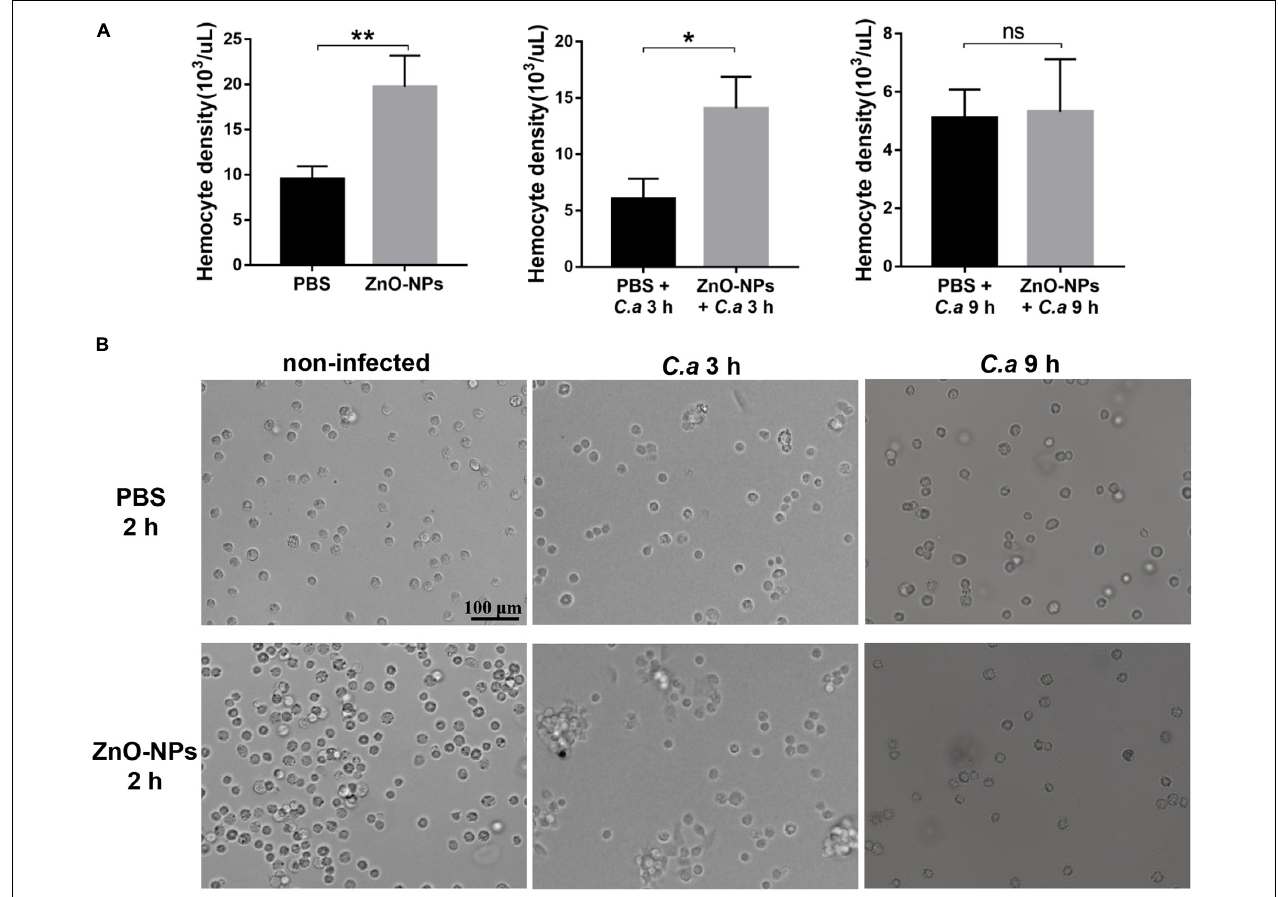
FIGURE 5 | The density and aggregation of hemocytes in ZnO-NP-pretreated G. mellonella with/without C. albicans challenge. (A) Quantification of hemocytes in ZnO-NP-pretreated G. mellonella with/without C. albicans infection. Differences were determined by using the t-test. * p < 0.05; ** p < 0.01. (B) Representative photomicrographs showing the aggregation of hemocytes in ZnO-NP-pretreated G. mellonella with/without C. albicans infection. Hemocytes formed small aggregates in response to the administration of ZnO-NPs in the absence of C. albicans infection. After 3-h exposure to C. albicans , intense aggregation of hemocytes was observed in ZnO-NP-pretreated G. mellonella . Scale bar, 100 µ